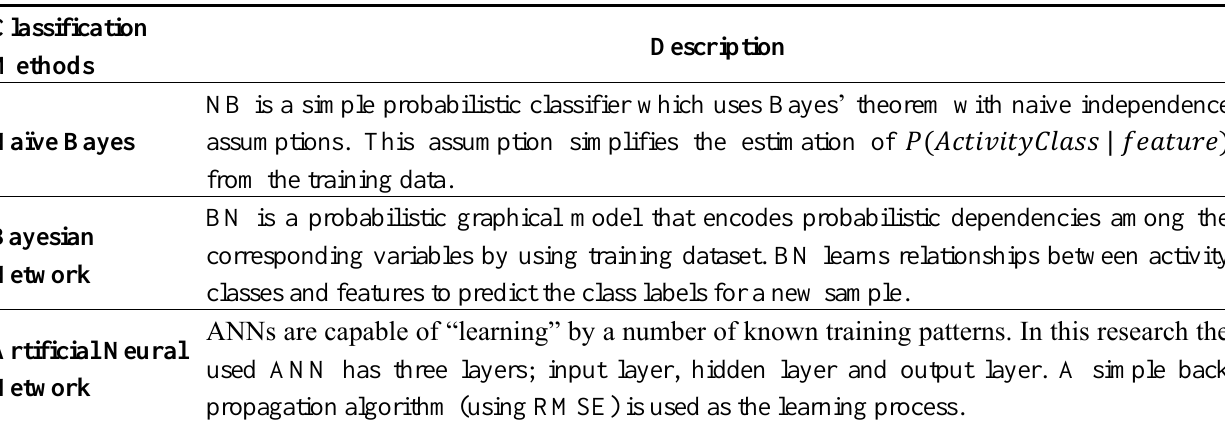
Table 3. Categorization of the classification